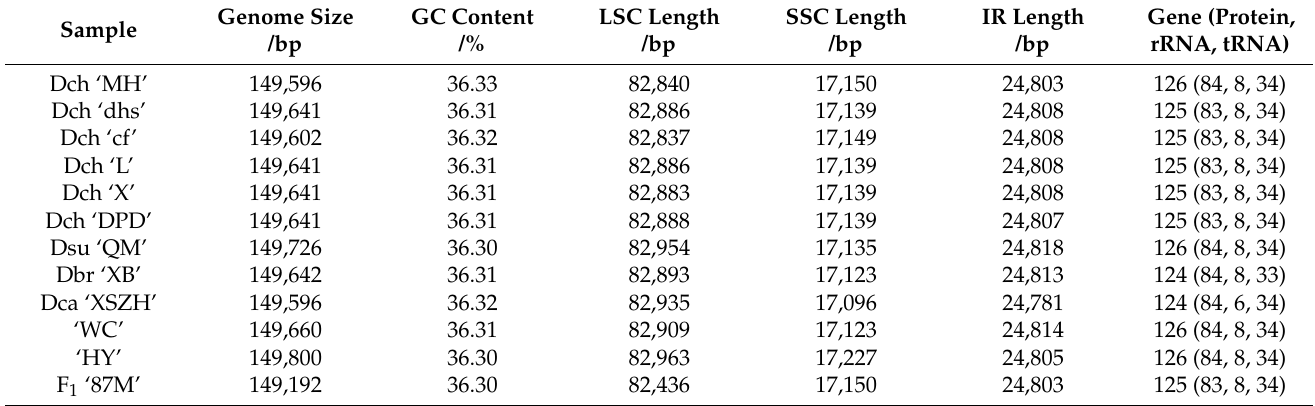
Table 1. Characteristics of the Dianthus chloroplasts generated in this study.